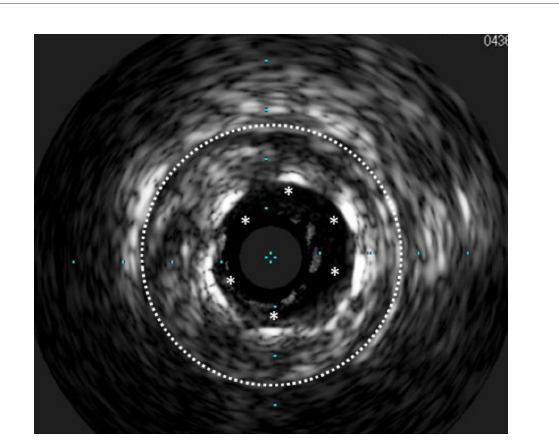
FIGURE4 Cracks in the subintimal calcium after coronary lithotripsy.